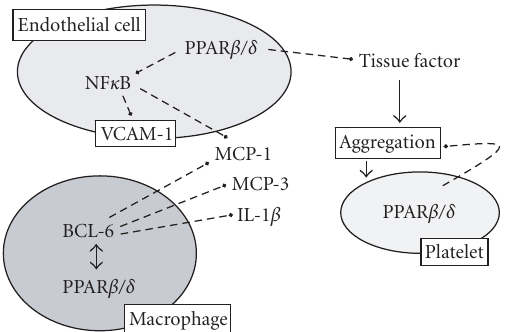
Figure 2: Antiinflammatory/anticoagulation pathways of PPAR β / δ . PPAR β / δ activation in endothelial cells reduces NF κ B activation and the induction of vascular cell adhesion molecule (VCAM)-1, and monocyte chemoattractant protein (MCP)-1, along with the release of tissue factor. PPAR β / δ is expressed in platelets and mono- cytes/macrophages. PPAR β / δ ligands reduce platelet aggregation via a rapid nongenomic mechanism. In macrophages, PPAR β / δ lig- ands release the transcriptional corepressor BCL-6 from its complex with PPAR β / δ . Free BCL-6 suppresses the release of MCP-1, MCP- 3, and IL-1 β